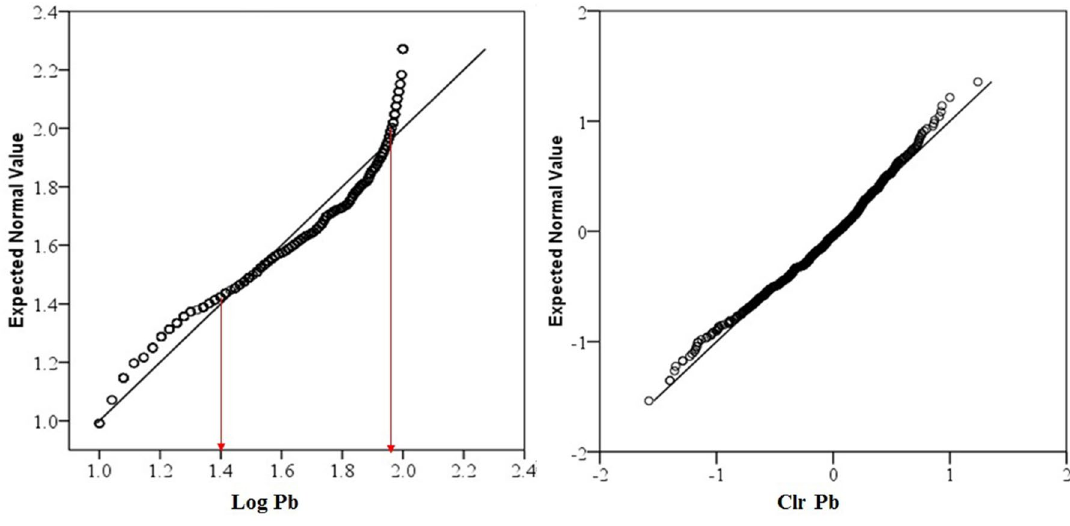
Figure 3. Q–Q plot of: (a) Pb original log-transformed data; (b) Pb clr-transformed